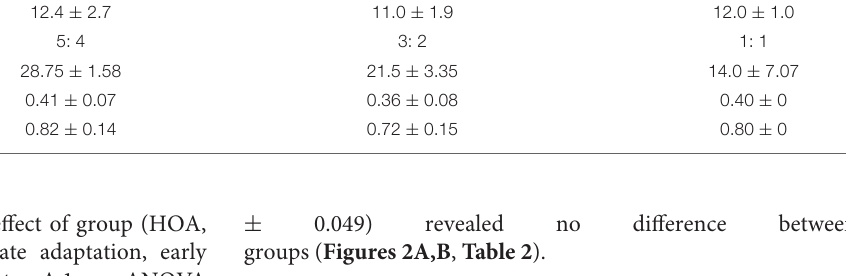
FIGURE 1 | period involved 1-min walking with belts tied at the slow speed, followed by 1min tied at the fast speed. (B) Step symmetry for individual participants throughout the duration of the experiment. Strides that occurred during tied belt walking are depicted as a darker color than the lighter-colored split-belt walking strides. Baseline walking is shown prior to the first dotted line, split-belt walking adaptation period is shown between the dotted lines, and de-adaptation walking trials can be found after the second dotted line. Note that the HOA participant data are shown in green circles, MCI participant data in purple filled triangles, AD participant in purple unfilled triangles.